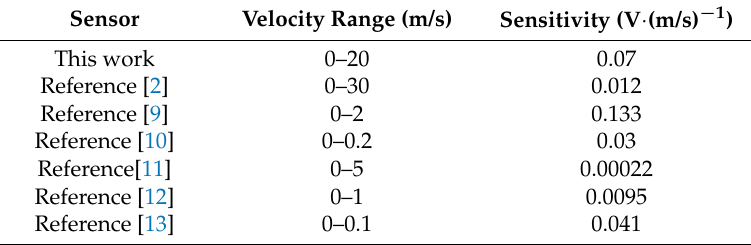
Table 1. Comparison of sensitivity for relevant 2D wind sensors.